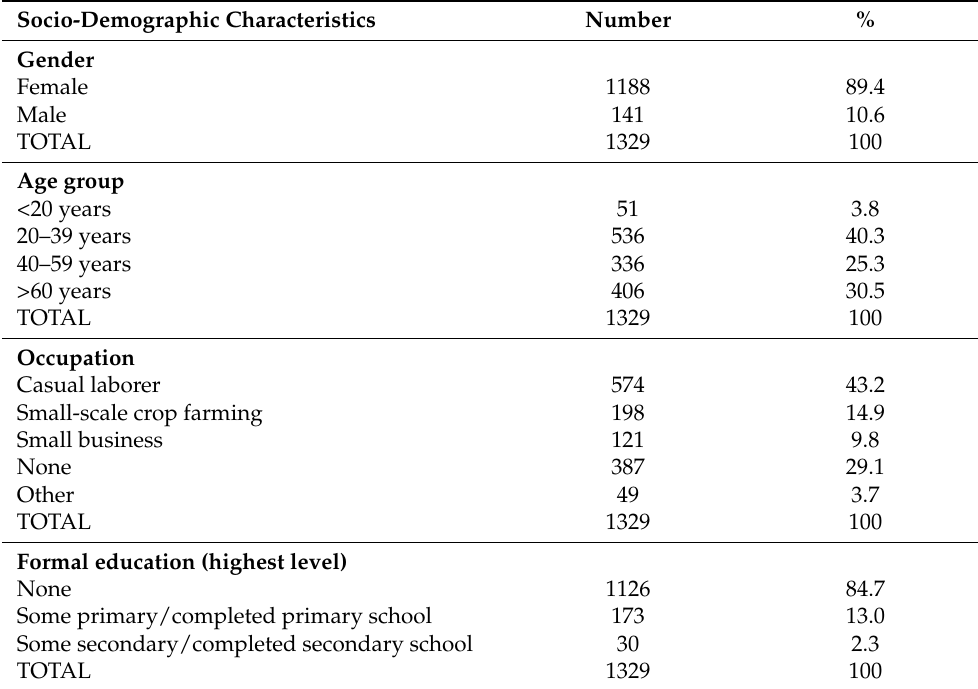
Table 1. Sociodemographic characteristics of the 1329 questionnaire